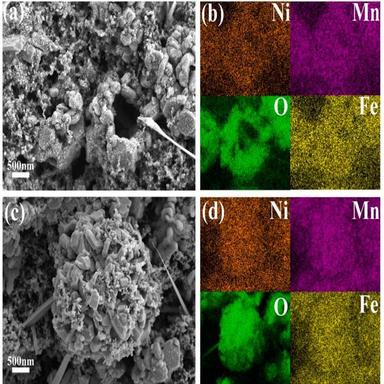
SEM and EDS mapping of (a, b) NFM samples (c, d) NFM-1 %Zr samples.